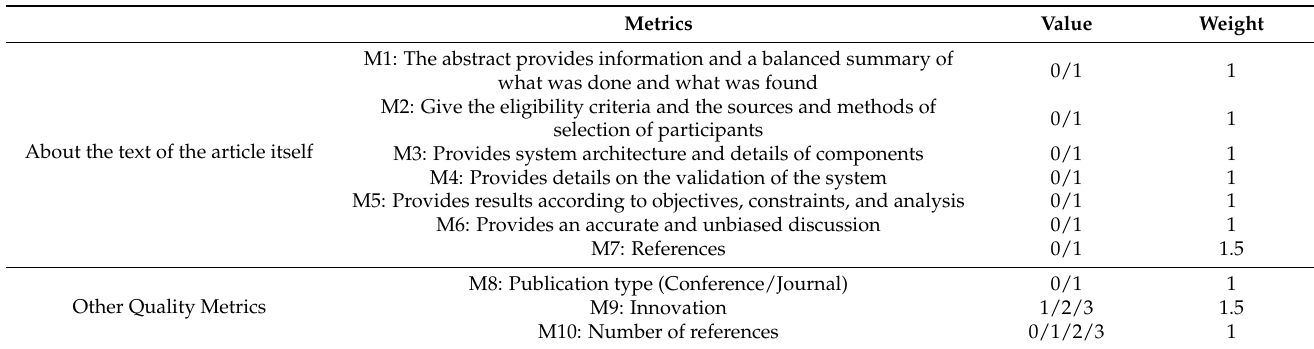
Table 4. Quality